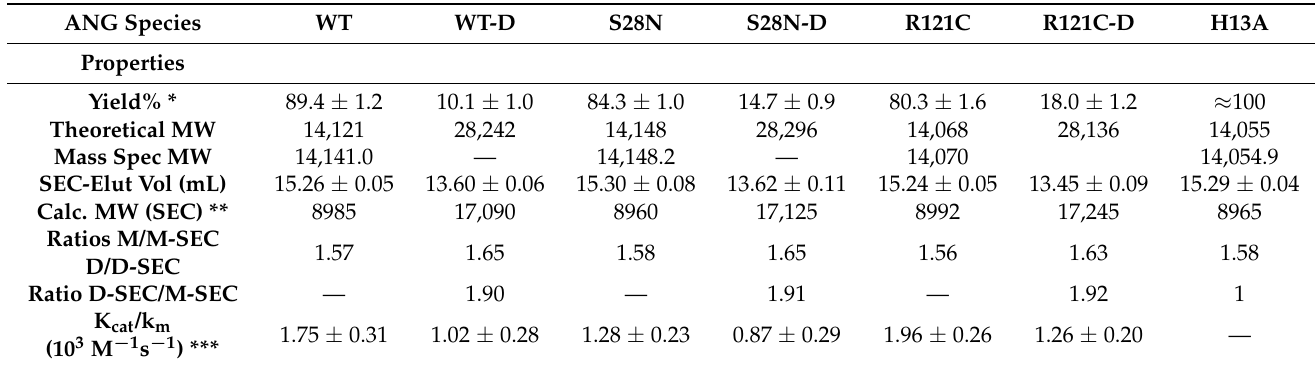
Table 1. MW of the ANG variants, percentages of M and D formed, and enzyme activity